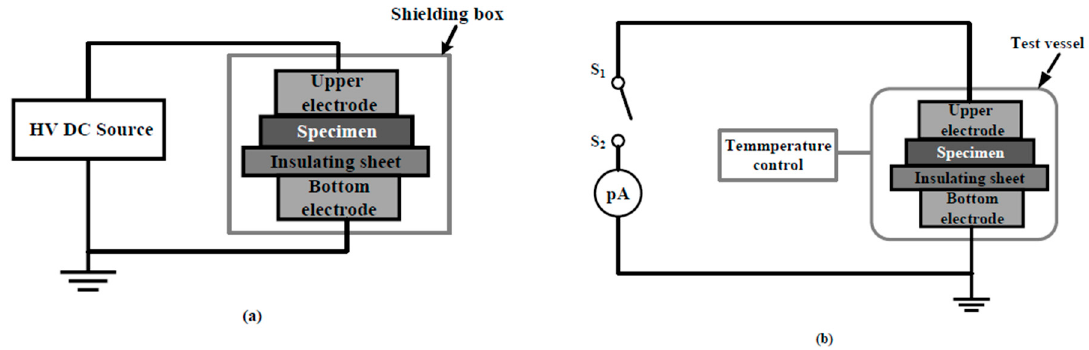
Figure 4. Schematic diagram of the thermal-stimulation depolarization currents (TSDC) experiment setup. ( a ) Polarization setup; ( b ) schematic of Novocontrol system.